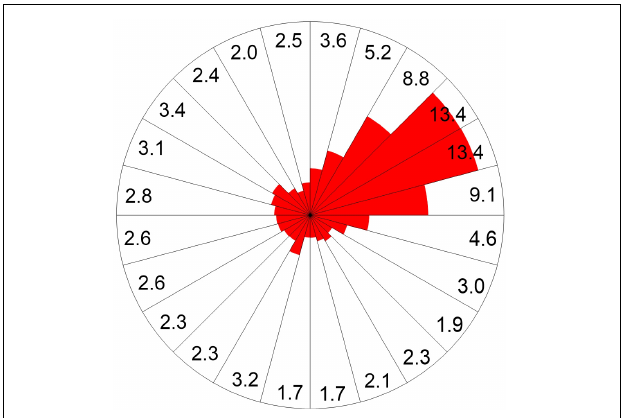
FIGURE 3 | Distribution of the cumulative wind stress (in percent) in the mid-point of cross-section S1 for a 10-year period (2010–2019) depending on direction of the wind velocity vector.